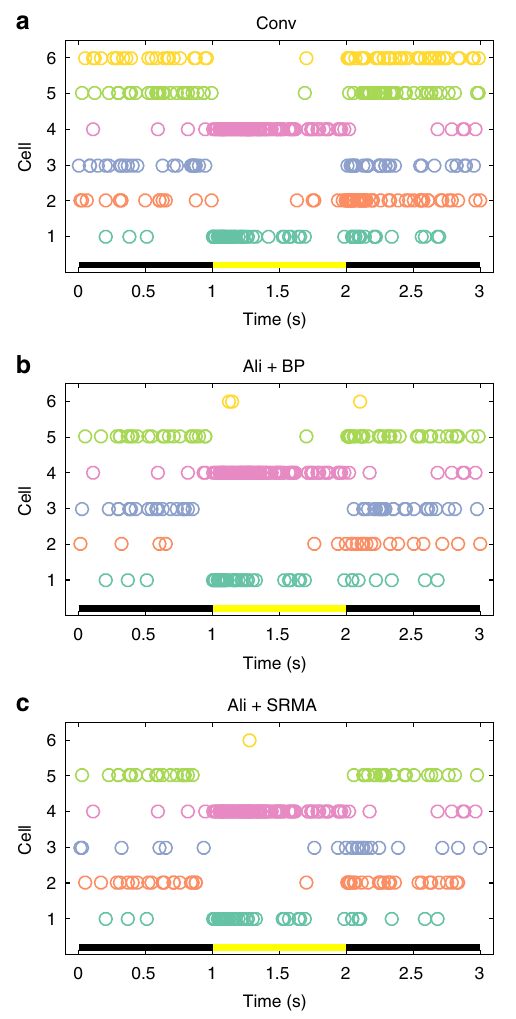
Fig. 2 Impacts of aliasing on spike sorting performance. a Conventional, non-aliased recordings. b Aliased recording with band-pass fi ltering. c Aliased recording with SRMA